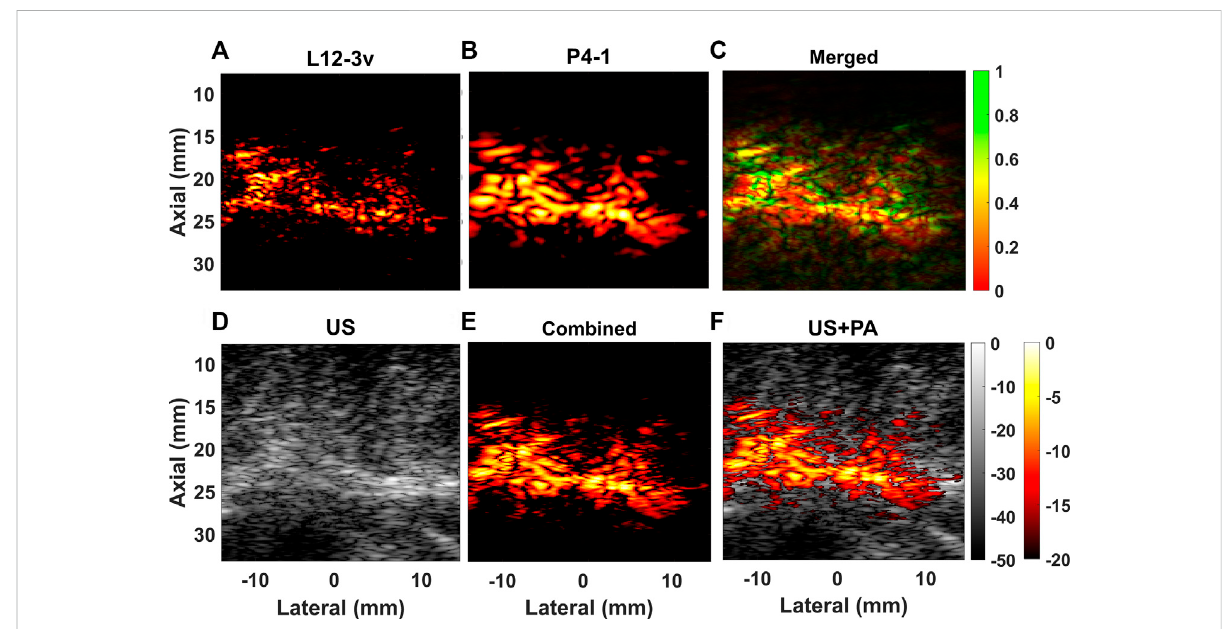
FIGURE 8 ReconstructedPAB-modeimagesobtained fromthebovinetissuesamplewith (A) L12-3v (B) P4-1aredisplayedand (C) mergedimageofL12- 3v and P4-1is displayed., Figure (D) shows the US B-mode acquired with L12-3v, (E) shows combined and compensated image and (F) shows a superposition of (E) on (D) .